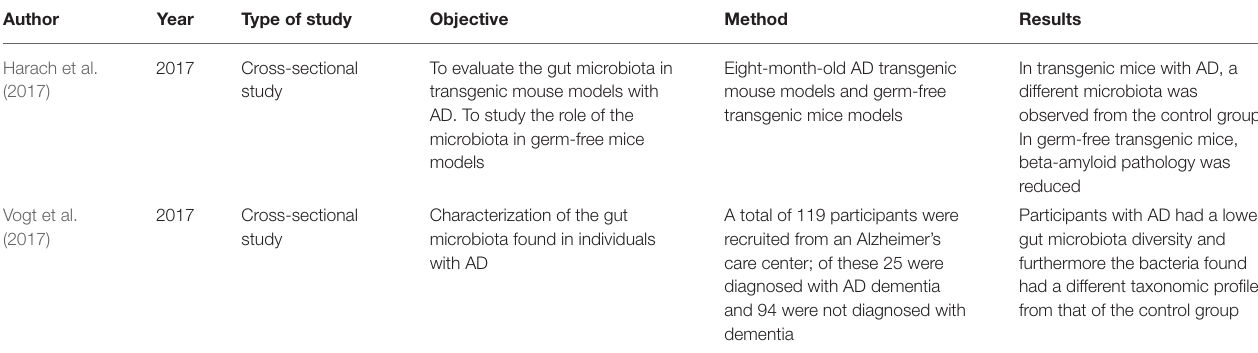
TABLE 1 | Microbiota and Alzheimer’s disease (AD).